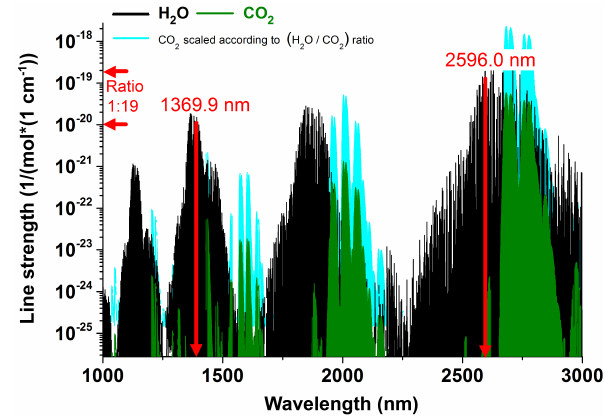
Figure 2. HITRAN 2008 line strength plot (Rothman et al., 2009) for CO 2 (green) and H 2 O (black). The turquoise spectrum in the back shows the scaled (factor 39) CO 2 line strengths for visualiza- tion of the stratospheric situation with a low water vapor content (10ppmv) and standard CO 2 (390ppmv)